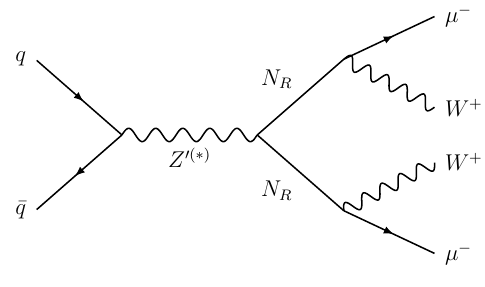
Figure 1 . RH neutrino pair production via an s-channel Z 0